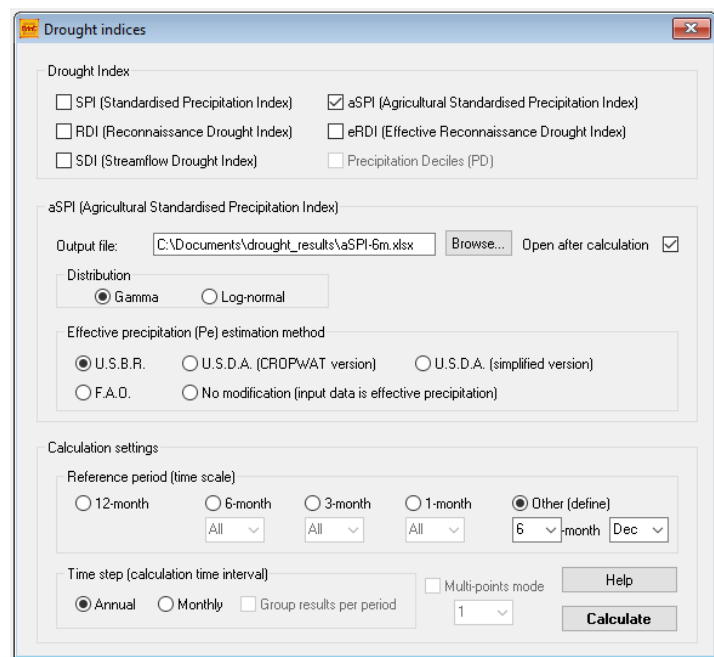
Figure 5. Drought indices calculation settings.